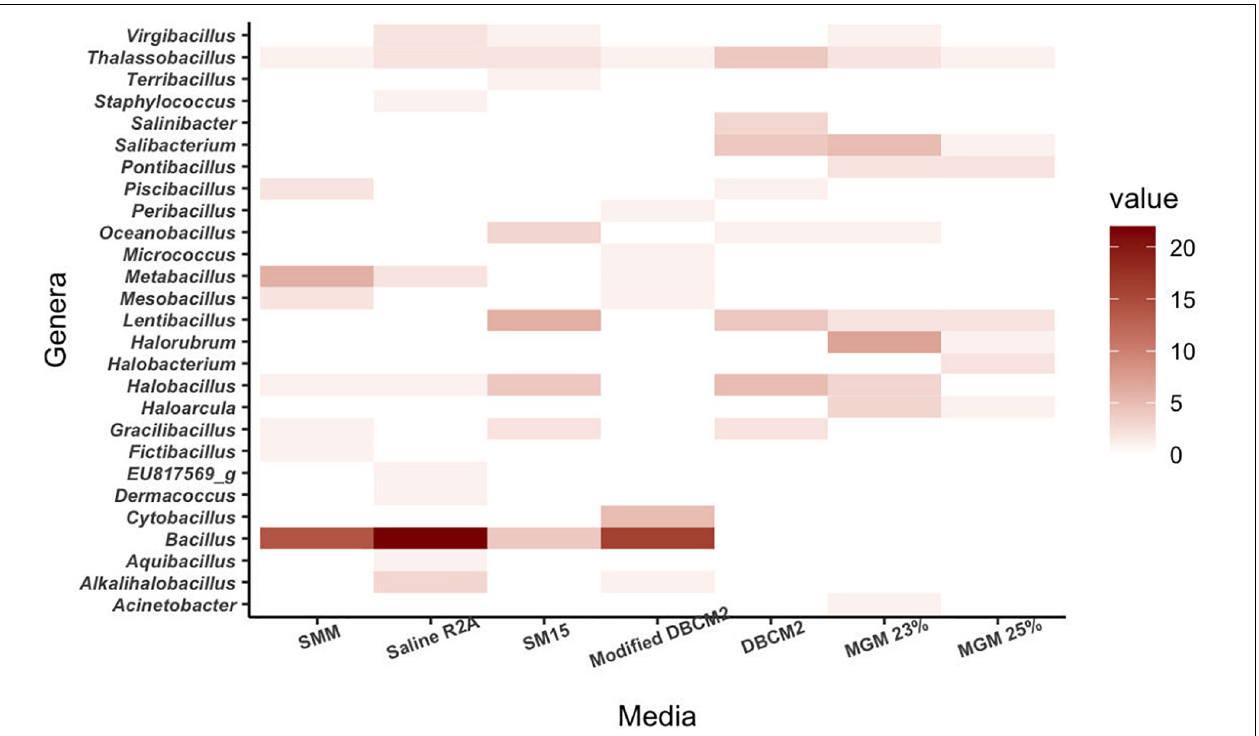
FIGURE 1 | Bacterial and archaeal genera from table salts recovered on culture media with different salt concentrations and nutritional compositions. SMM and saline R2A are supplemented with 10% w/v total salt, while their nutritional compositions are different. SM15 contains 17% w/v total salt. Modified DBCM2 and DBCM2 have 2.5% w/v total salt, 25% w/v total salt, respectively. MGM was also especially used for the isolation of archaea, supplemented with 23 and 25% w/v total salt. The color code indicates the number of microorganisms isolated on each